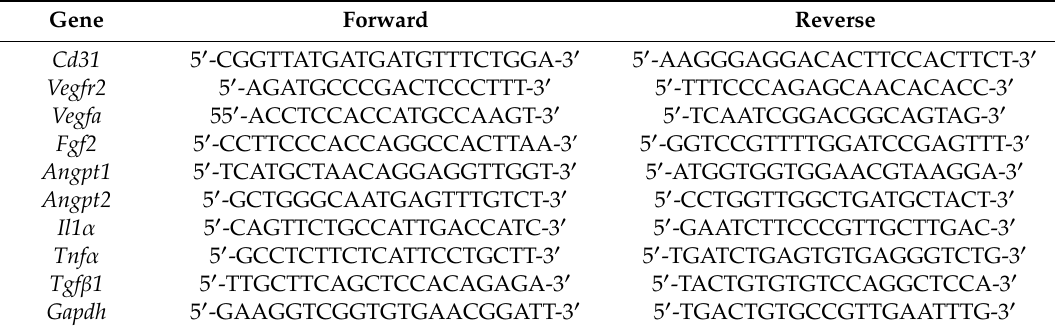
Table 1. Oligonucleotide primers used for RT-qPCR